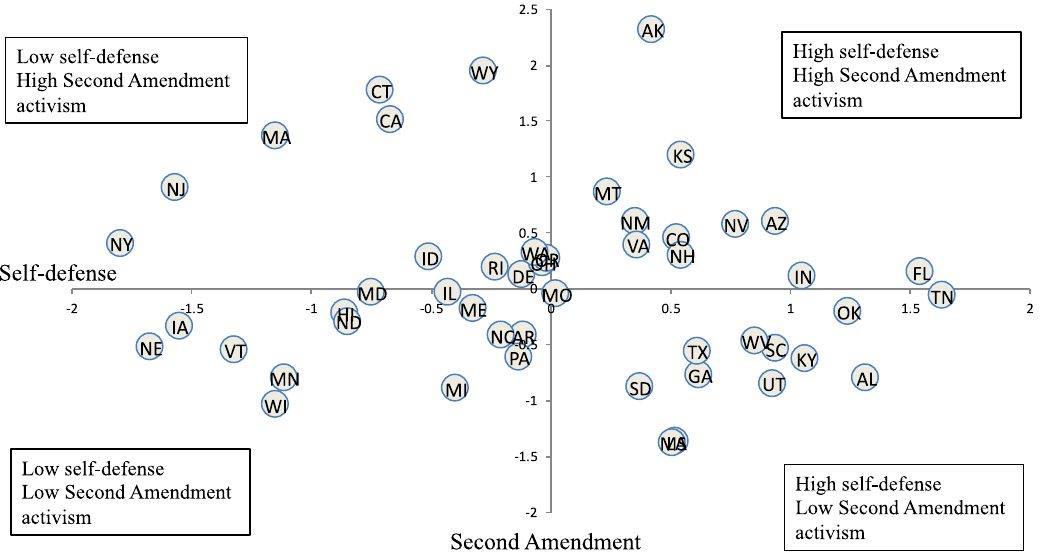
Fig. 4 Mix of state subcultures: Self-Defense/Second Amendment. Self-Defense/Second Amendment. Standardized component scores (representing the difference for a particular state from the mean for all states expressed in number of standard deviations) are shown for Self-Defense on the x -axis and for Second Amendment activism on the y -axis.